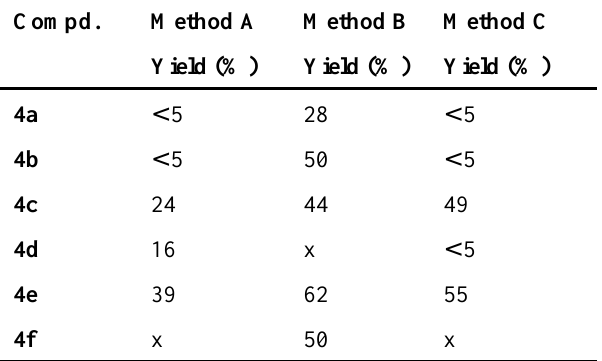
Table 1. Yields of required maleimides related to synthetic